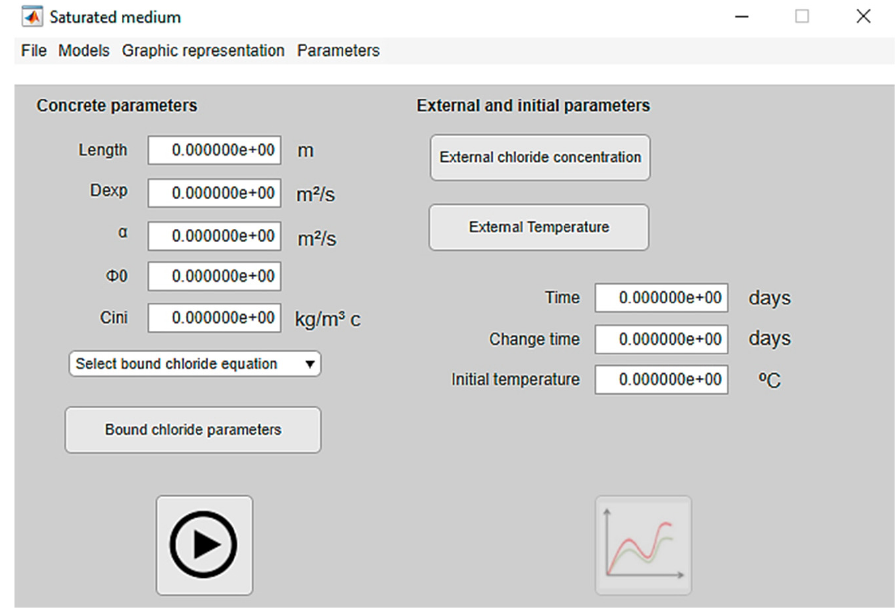
Figure 6. Screen of input data for saturated problem.